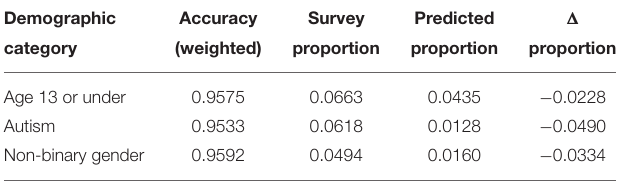
TABLE 6 | Classification performance for three demographic